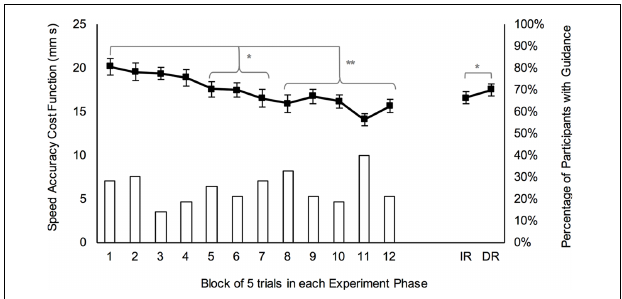
FIGURE 3 | Overall performance efficiency (as measured by the speed accuracy cost function; line graph with SE bars) and percentage of all participants performing with haptic assistance (bar graph) for each phase of the experiment. Blocks of acquisition are numbered 1 through 12 and retention tests are IR (immediate retention) and DR (delayed retention). ∗ p < 0.05, ∗∗ p <